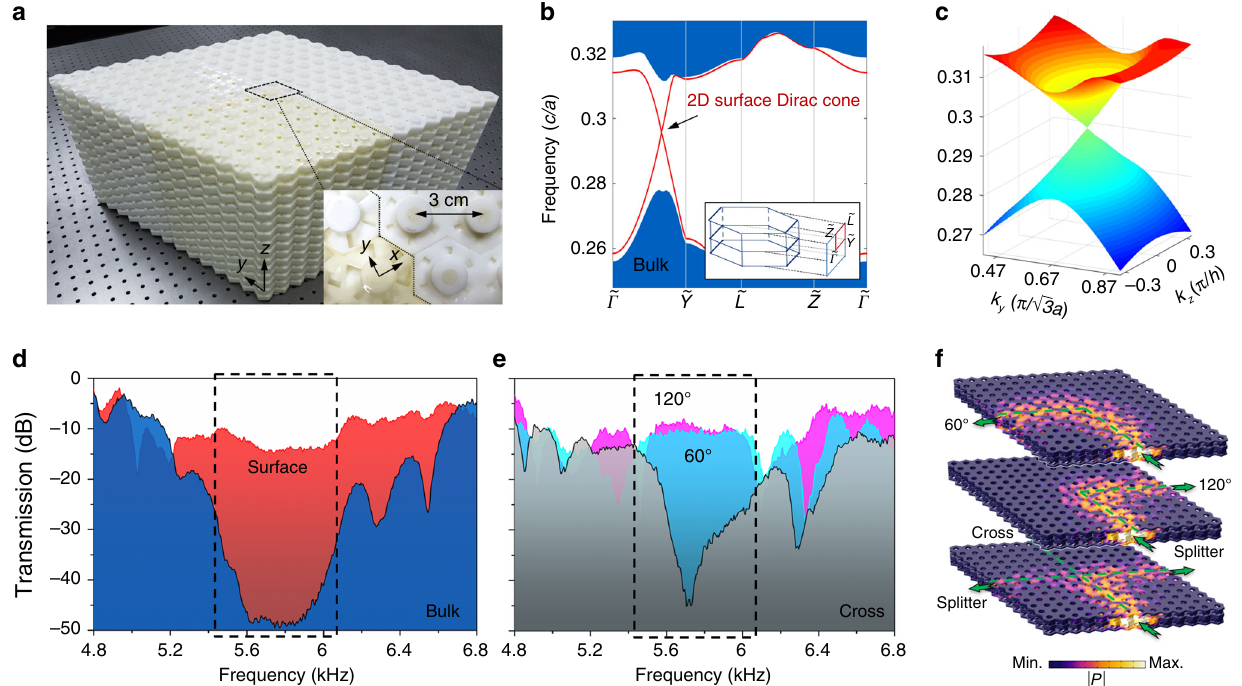
Fig. 2 Topological surface on yz -domain wall. a Picture of the experimental sample constructed by four rhomb – prisms. Each segment has 7×7×7 unit cells (e.g. a yellow rhomb – prism). The inset shows a top-down view of the zigzag interface. b Projected bandstructures in the k yz plane, where the red lines represent the gapless Dirac-like surface states. The inset shows the highly symmetric directions of the surface Brillouin zone. c 3D view of the simulated surface Dirac cone. d Measured transmission spectra for the domain wall (red) and the bulk (blue) along the ~ Γ ~ Y direction. The dashed box indicates the frequency range of the bulk bandgap. e Measured transmission spectra for a 60° bend (cyan), a 120° bend (magenta), and a splitter con fi guration (grey). f Slices of the simulated acoustic pressure distribution at a frequency of 5.8kHz, where the colour scale represents the absolute value of acoustic pressure (P).